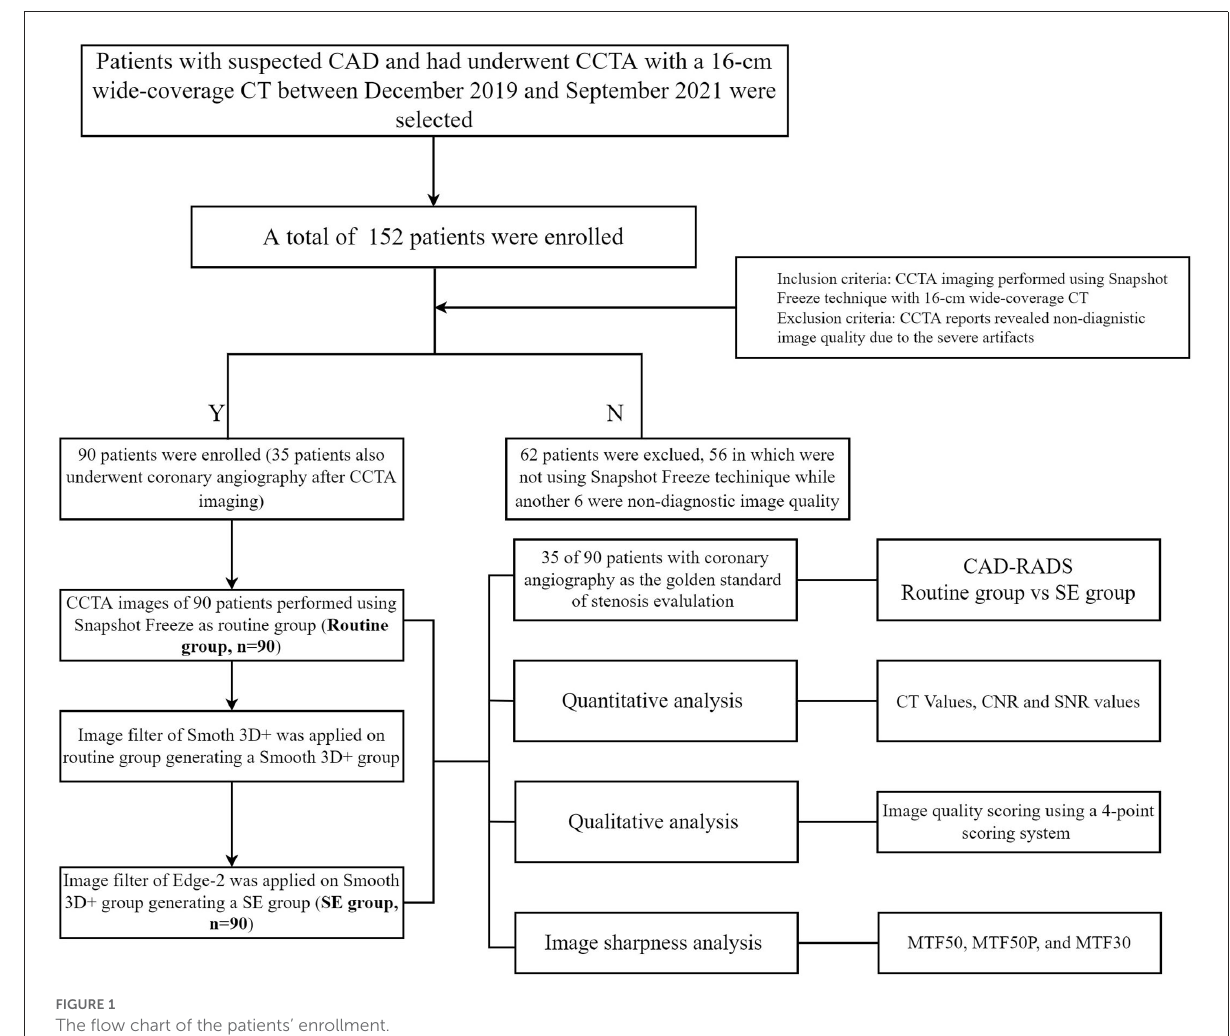
FIGURE1 The flow chart of the patients’